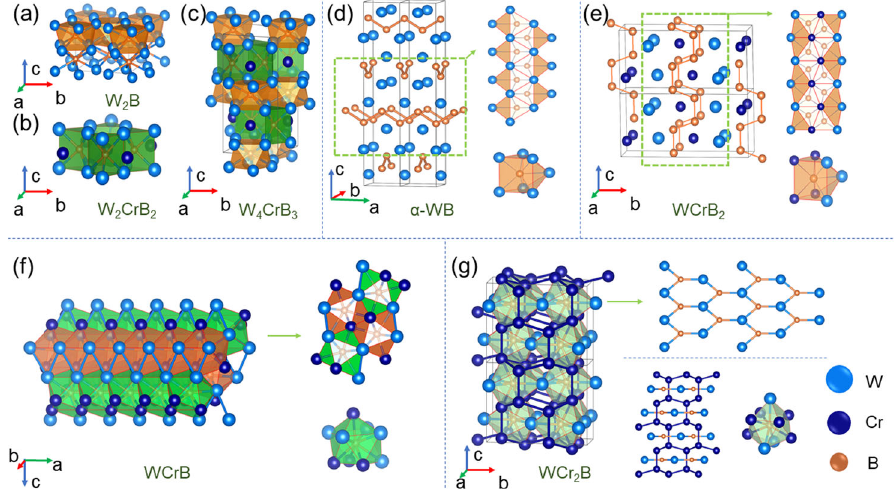
Fig. 4 Crystal structures of the phases in the W – Cr – B system. a W 2 B, b W 2 CrB 2 , c W 4 CrB 3 , d α -WB, e WCrB 2 , f WCrB, and g WCr 2